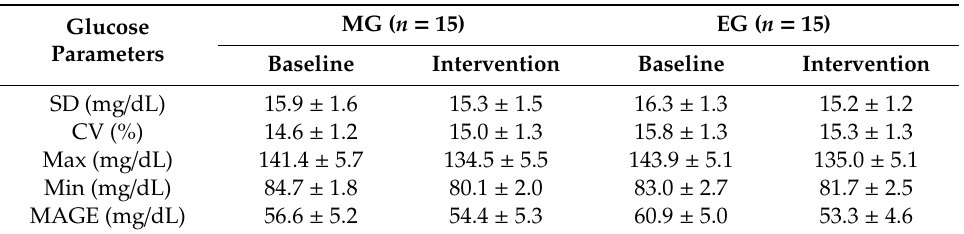
Table 2. Changes in glucose parameters in both